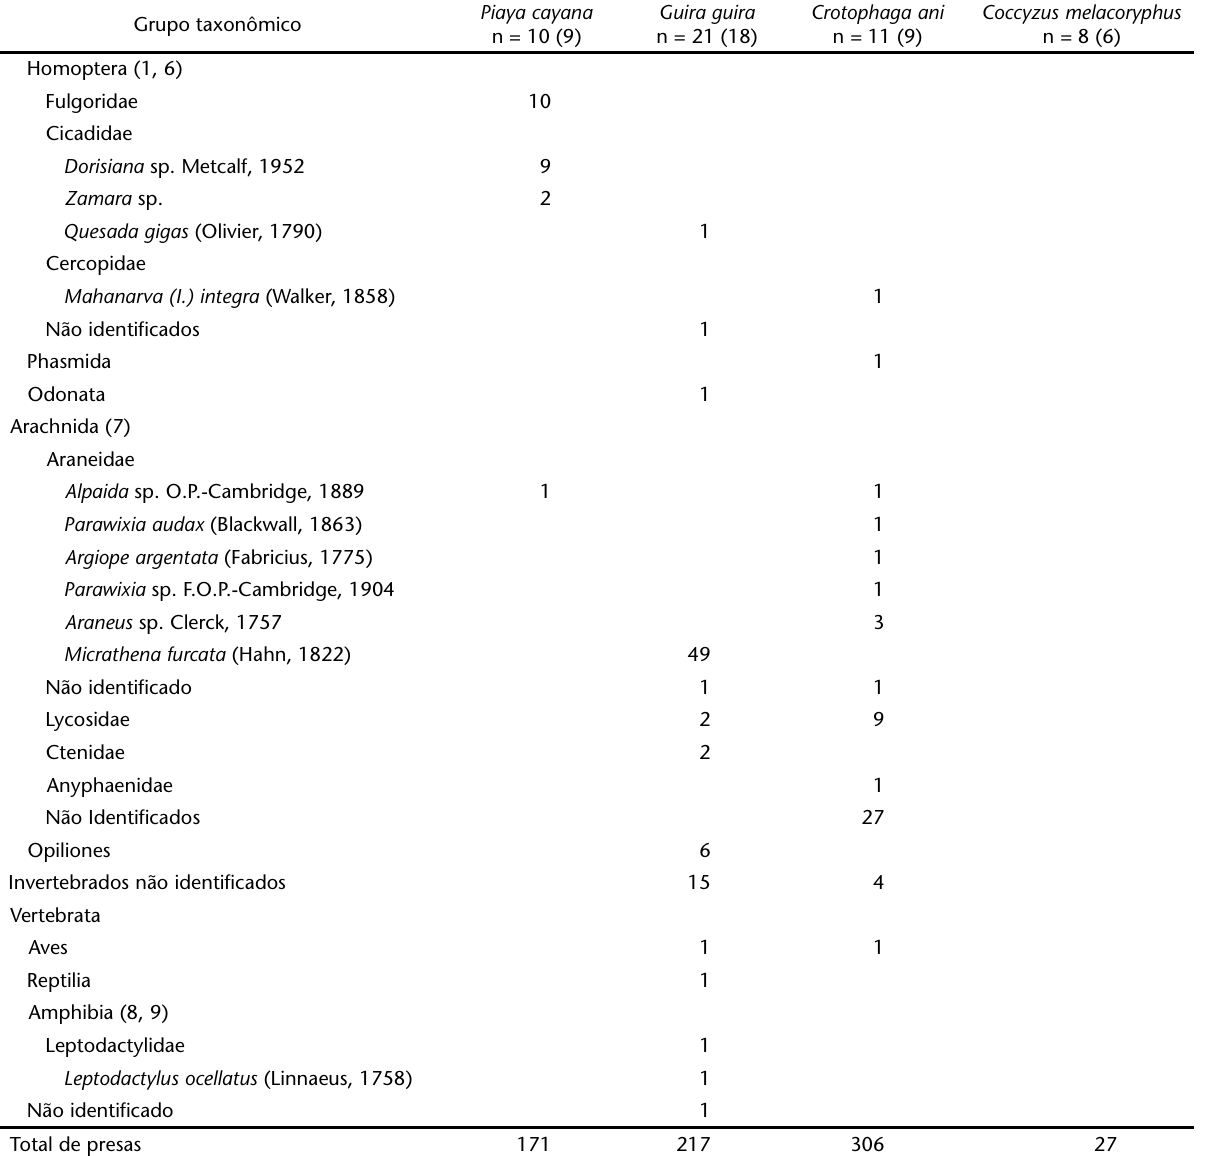
(Fig. 3 e Tab. I). Teve destaque na sua dieta a predação de três grupos distintos de vertebrados: anfíbio, réptil e ave, bem como a variedade de Acrididae (Orthoptera), além de aranhas de uma única espécie, Micrathena furcata (Hahn, 1822) (Araneidae) (Tab. I). Igualmente variada mostrou-se a alimentação de C. ani , com- posta, sobretudo, por artrópodes. Orthoptera foi destacadamente o principal item ingerido, embora Araneae, Coleoptera, Hyme- noptera e Lepidoptera (larvas) também se mostraram